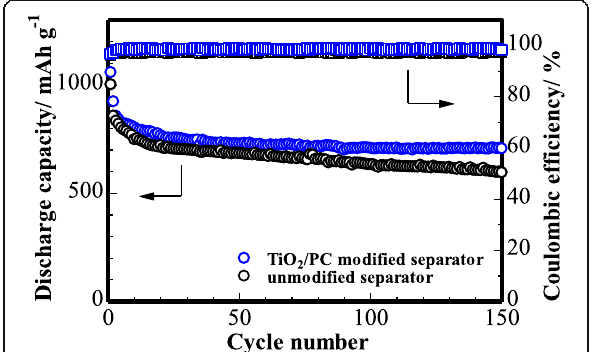
Fig. 9 Cycling stability of the cell (with TiO 2 /PC-modified separator and unmodified) at 0.1 C